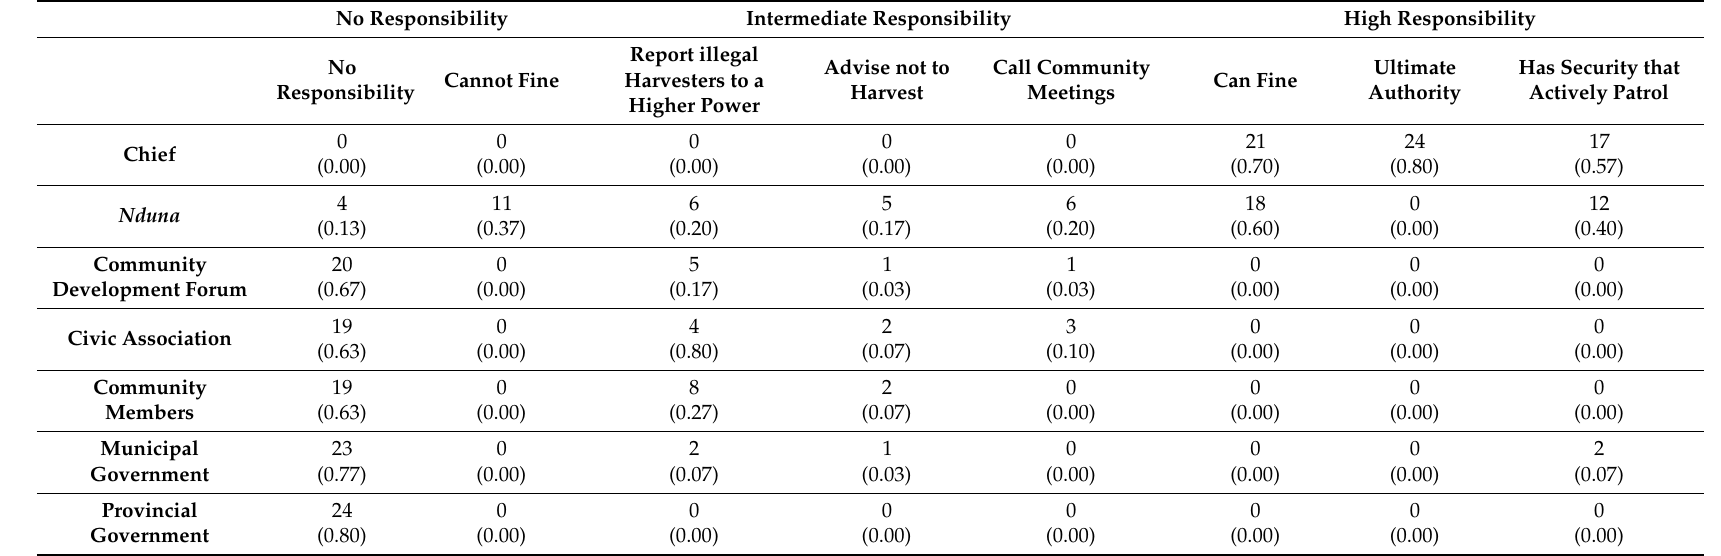
Table 2. The frequency of selected duties thought to be undertaken by different institutions as cited by community focus groups ( n = 30) pooled across all villages. Values in parentheses indicate the proportion of groups in which the duty was